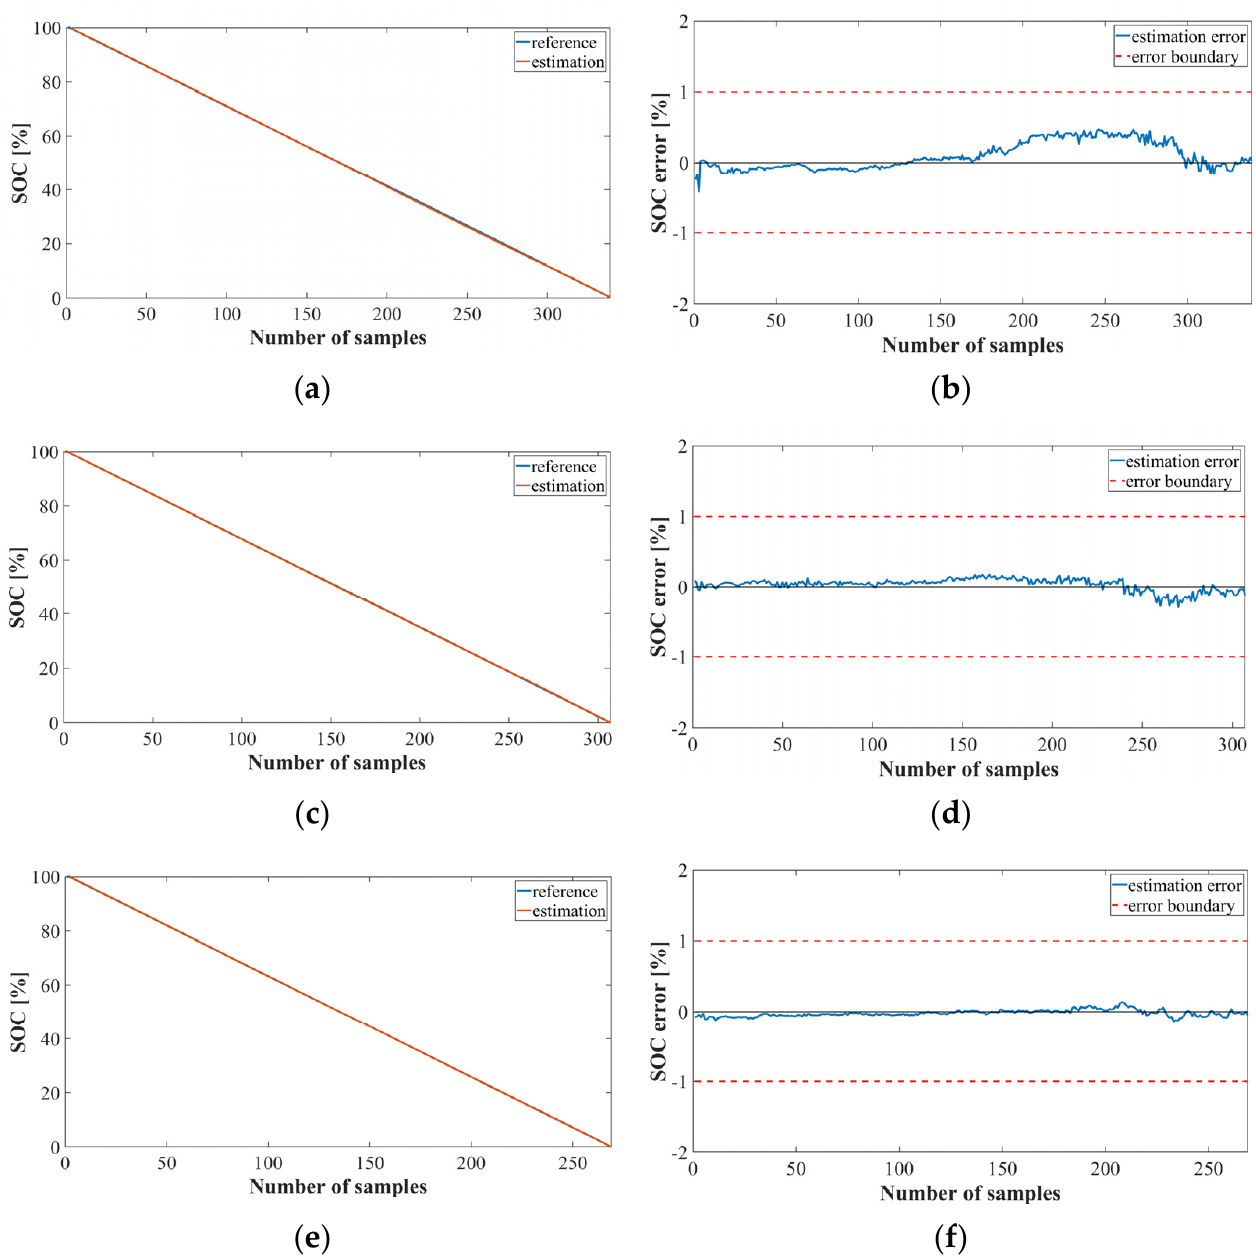
Figure 9. SOC estimation results for Method 2 using the MNN (NASA dataset): ( a ) SOC estimation